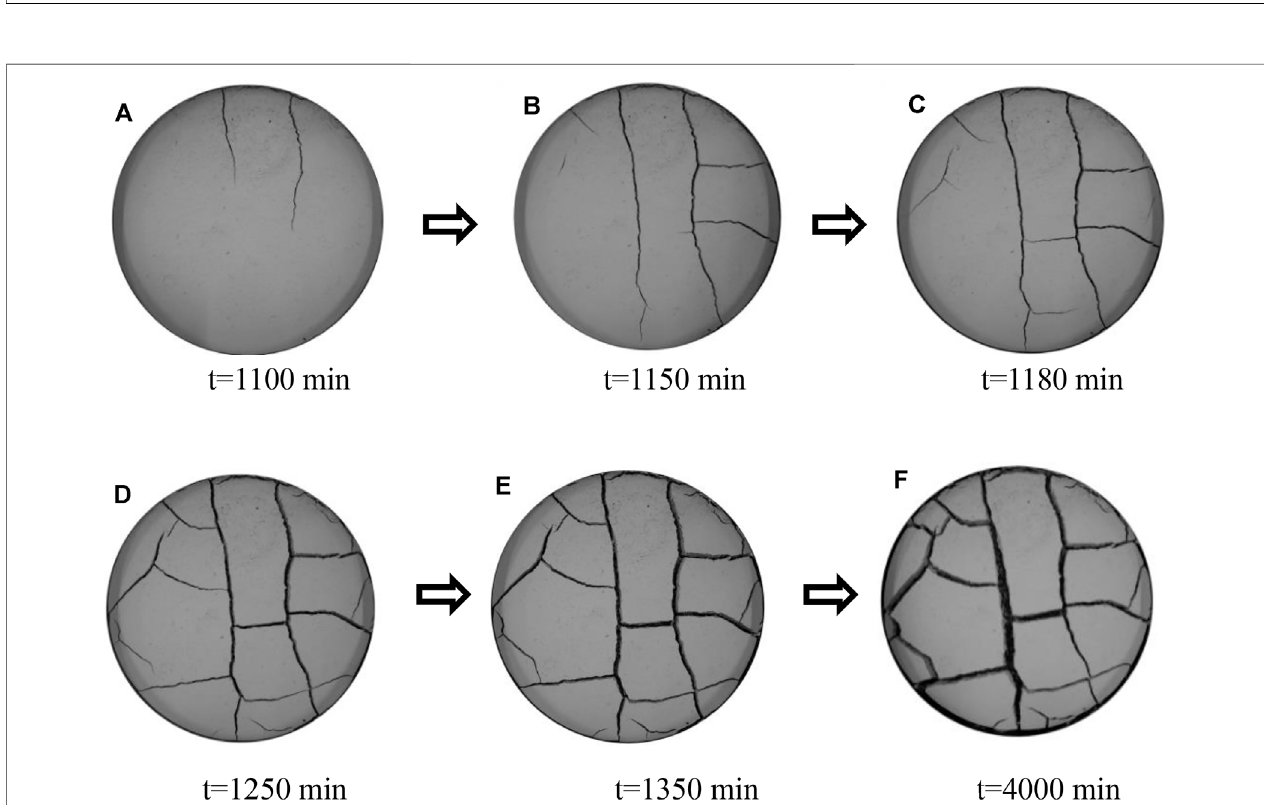
Frontiers in Earth Science |